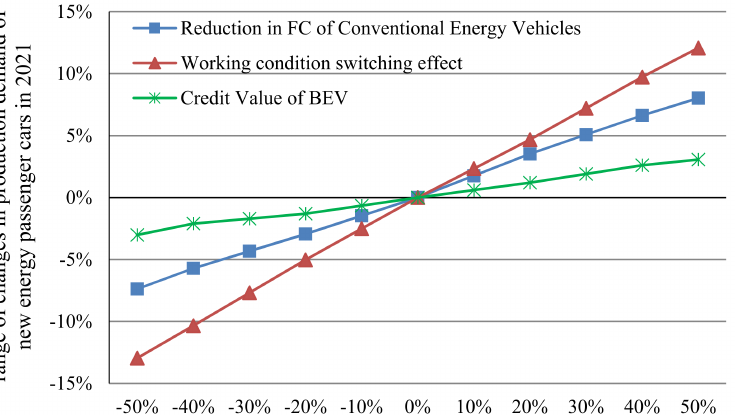
Figure 3. Sensitivity Analysis of Key Indicators and Production Demand for New Energy Passenger Cars in 2021 (Minimum Guarantee